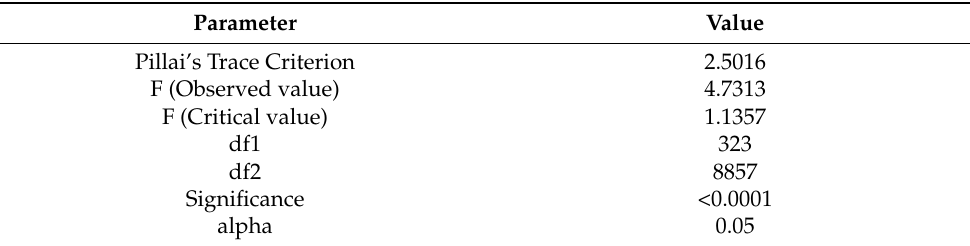
Table 4. Summary of the results of Pillai’s trace of equality of covariance matrices of canonical discriminant functions to determine the idoneity of data for discriminant canonical analyses to be